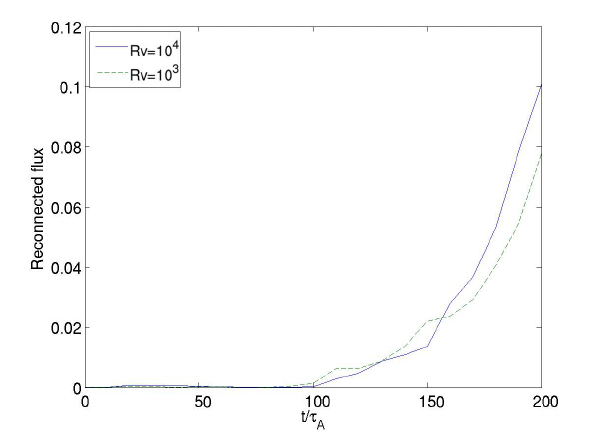
Fig. 10. Non-linear evolution of the initial 2-D helmet streamer equilibrium. Comparison of the time evolution for the reconnected flux in two runs with different viscosities ( R v = 10 3 and R v = 10 4 ) but equal resistivity S = 10 4